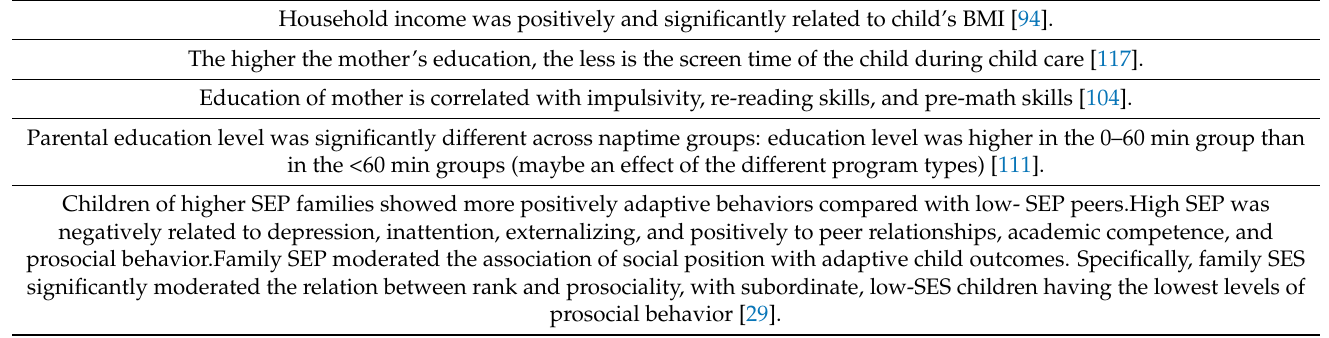
Table A2. Reported associations or moderations between family SEP with outcomes at the ECEC center level. Key